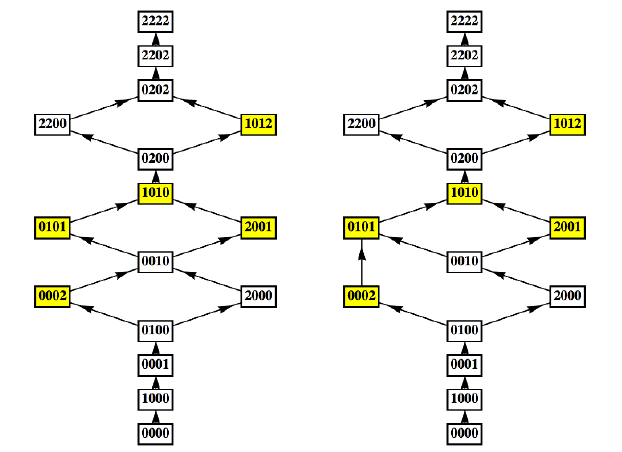
Figure 3 . F 4 nilpotent orbit Hasse diagram. The left hand diagram is derived from Hilbert series and HWG inclusion relations. The right hand diagram is taken from the mathematical Literature [29, 30]. Yellow nodes indicate non-normal nilpotent orbits.